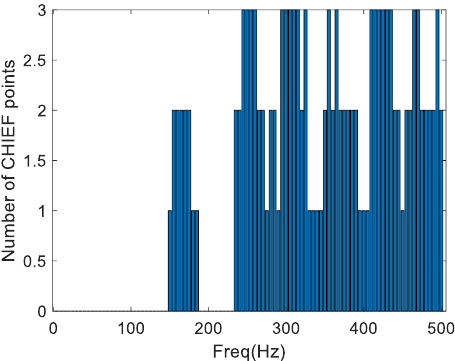
Figure 14. Number of CHIEF points considered for each frequency, when the optimization was performed for a maximum of three CHIEF points.